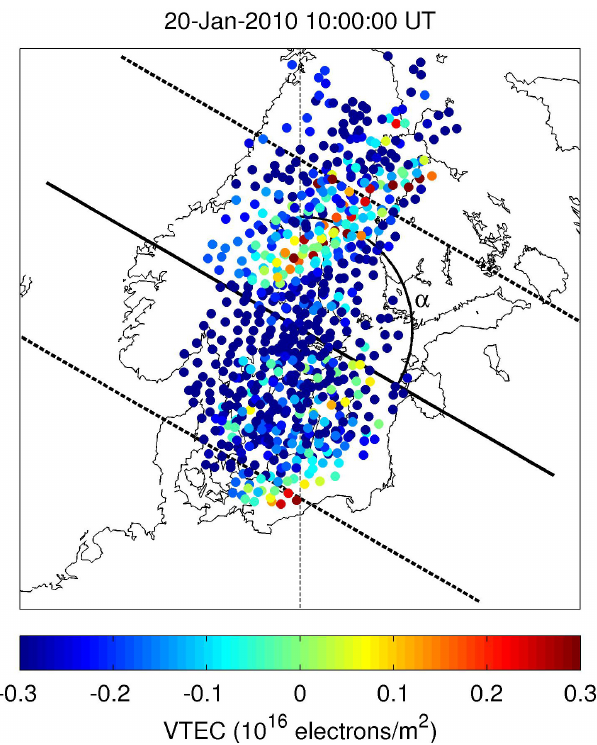
Figure 11. Illustration of the projection of VTEC data on a line of a specified azimuth angle. The thick solid line has an azimuth (“ α ”) of 120 ◦ . All measured IPPs between the two dashed lines are projected onto the solid line, and all corresponding VTEC values in the same 20km bin are